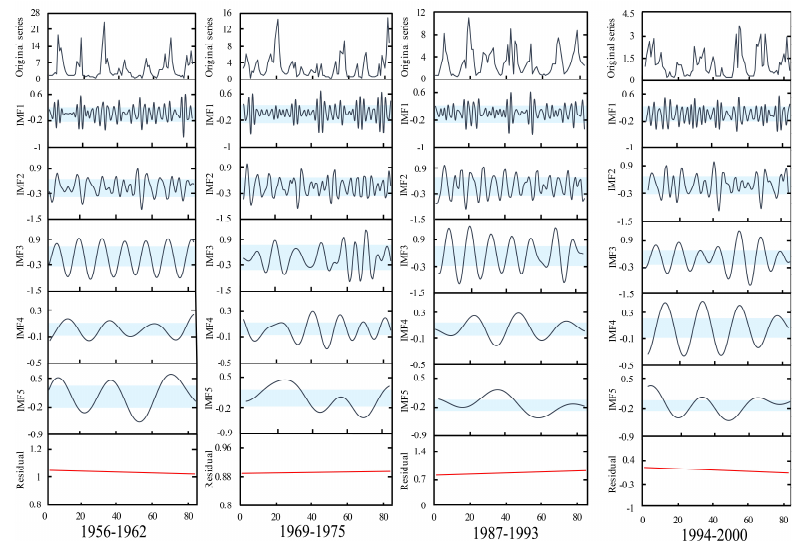
Figure 8. Segmented decomposed series of measured monthly runoff at Xianyang gauge.